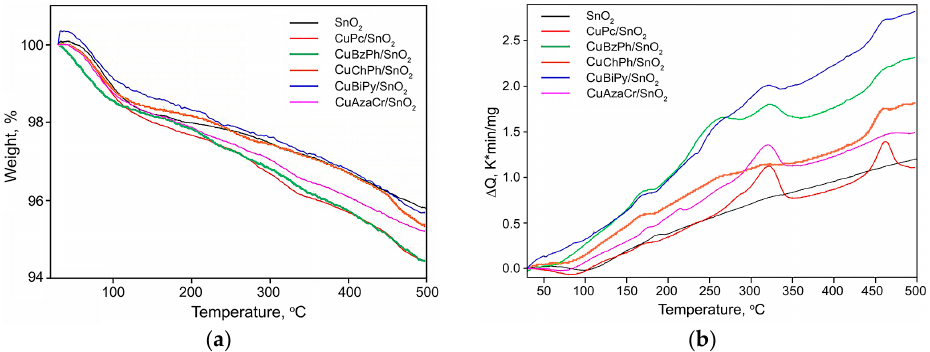
Figure 4. Weight loss ( a ) and DTA ( b ) curves of pure SnO 2 and hybrid samples.